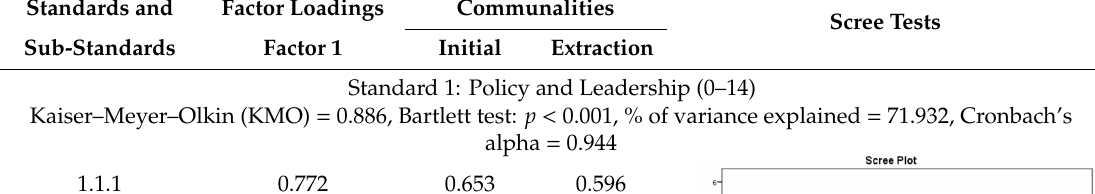
Table 3. Summary of the results from exploratory factor analyses (EFA) by stratification. Standards and Factor Loadings Communalities Scree Tests Sub-Standards Factor 1 Initial Extraction Standard 1: Policy and Leadership